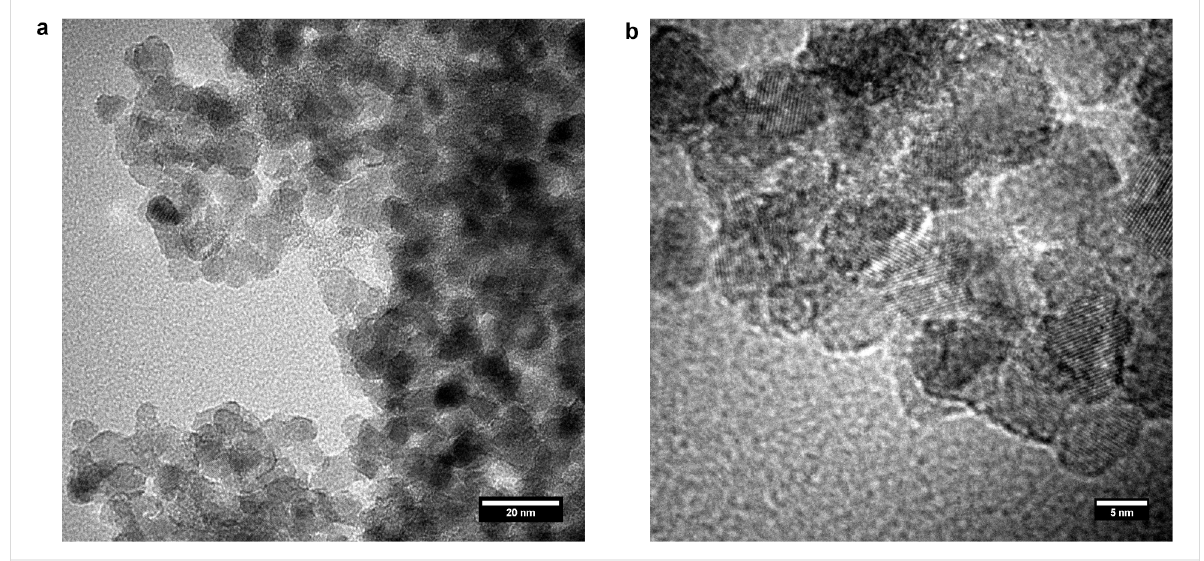
Figure 6: TEM images of the carbon coated TiO 2 nanoparticles.